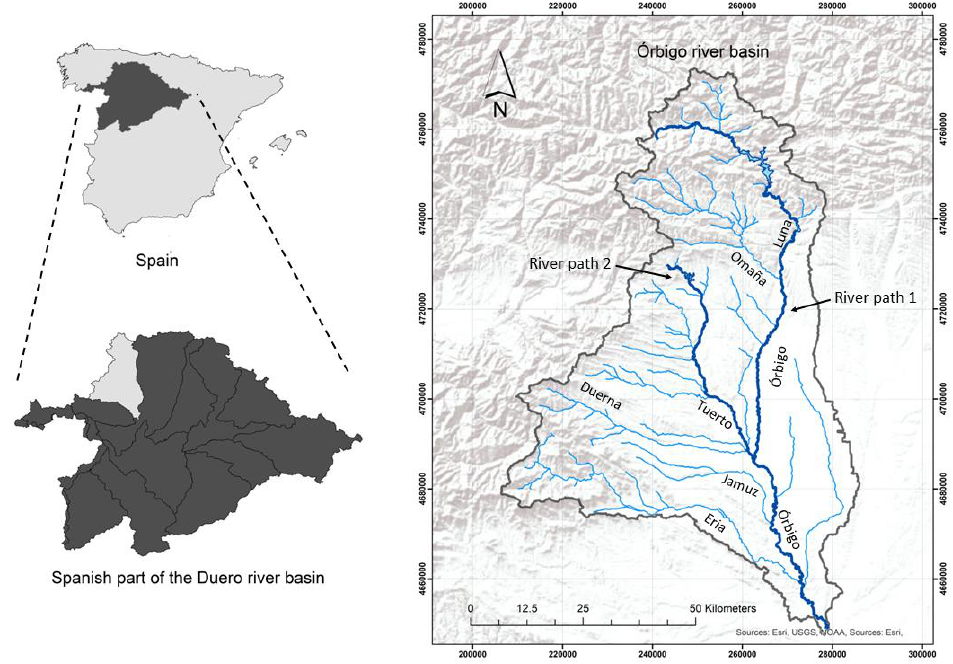
Figure 1. Location of the Spanish part of the Duero River basin, and the Ó rbigo River basin (north- western Spain). The main river sections of the Ó rbigo River Basin and the two river paths analyzed in this work are indicated in the right panel.